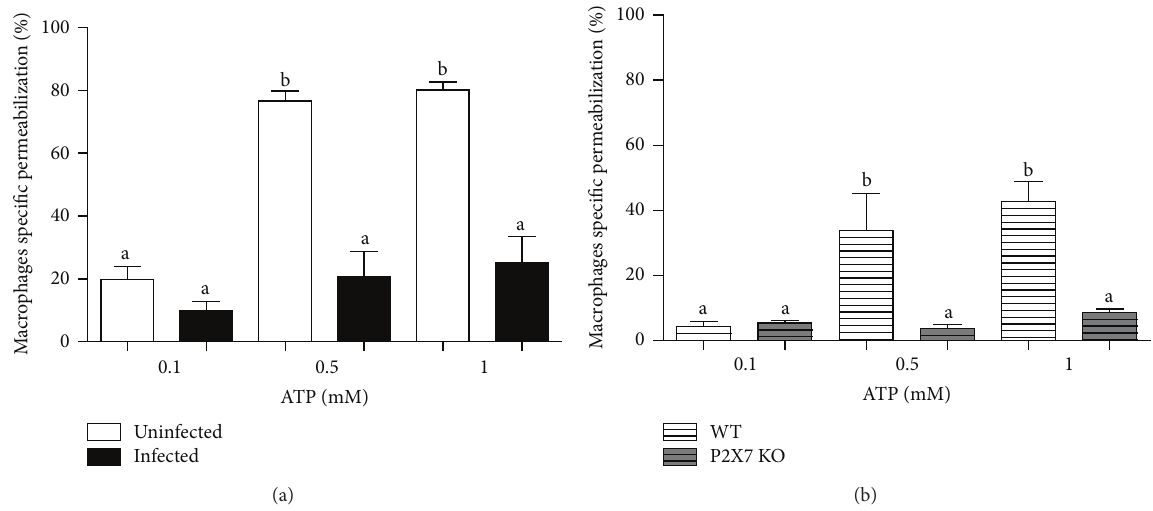
Figure 1: Evaluation of ATP-induced permeabilization in peritoneal macrophages, based on ethidium bromide (EB) uptake. (a) Peritoneal macrophages from S. mansoni -infected Swiss mice (black bars) were less sensitive to ATP-induced permeabilization than those from uninfected mice (white bars). (b) Peritoneal macrophages from C57BL/6 wild type mice (hatched white bars) respond to ATP-induced permeabilization unlike those from P2X7R KO mice (hatched gray bars). ATP-induced permeabilization values represent the % of EB uptake above basal levels by F4/80 positive cells and were expressed as mean and SEM. 𝑁 = 12 ( Swiss ) and 𝑛 = 6 − 9 (C57BL/6) replicates using different animals. (a) and (b) differ from each other with 𝑃 < 0.001 (one-way ANOVA followed by post hoc Newman-Keuls